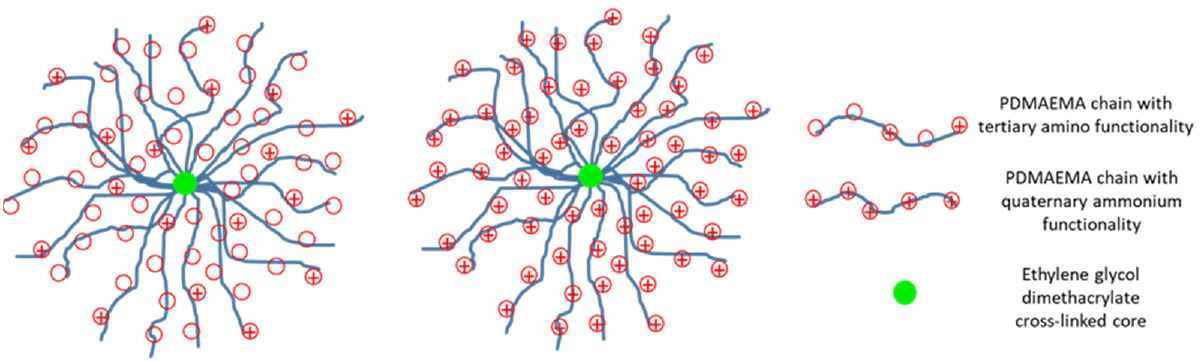
Scheme 1. Schematic presentation of the structure of the PDMAEMA-based star-like polymers.